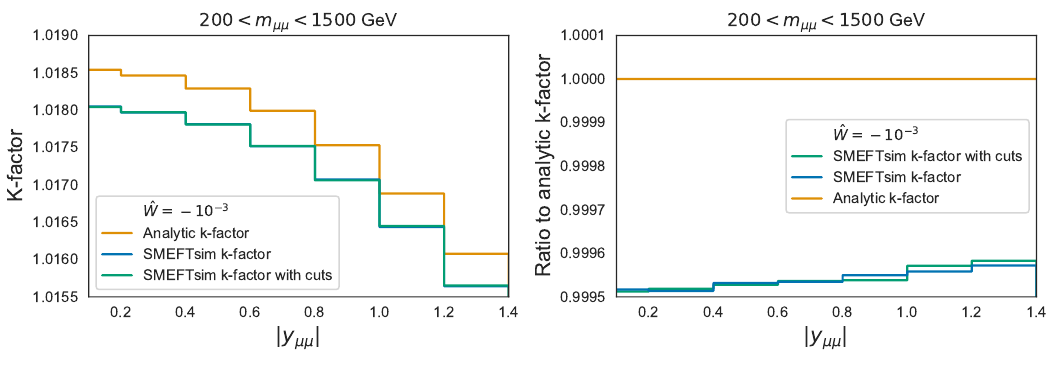
Figure 26 . Same as figure 25 (also for ˆ W = 10 − 3 ) for the EFT K -factors for the double-differential Drell-Yan cross sections in m ‘‘ and | y ‘‘ | , for the highest m ‘‘ bin of the CMS 7 TeV DY measurement. We only compute K -factors for | y ‘‘ | satisfying LO